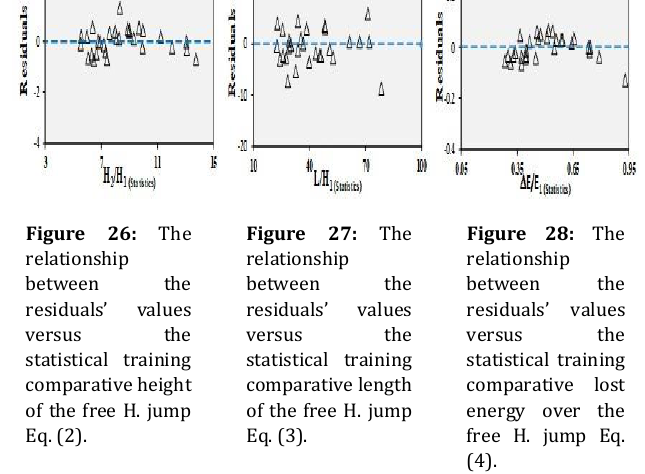
Figure 24: The relationship between the training values of the comparative length of the free H. jump Eq. (3) and the experimental measurements.